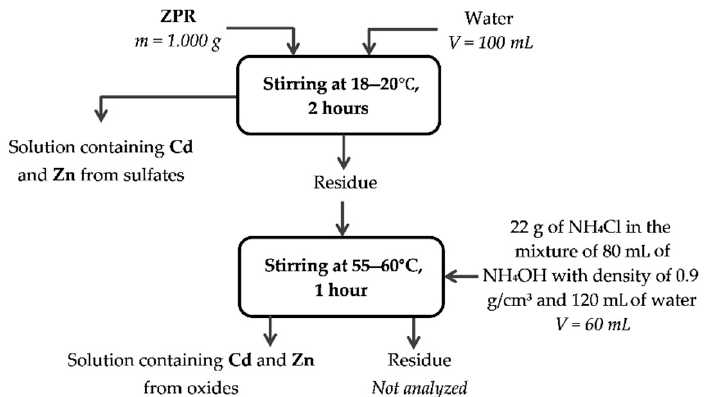
Figure A1. Method of chemical phase analysis of cadmium and zinc compounds.